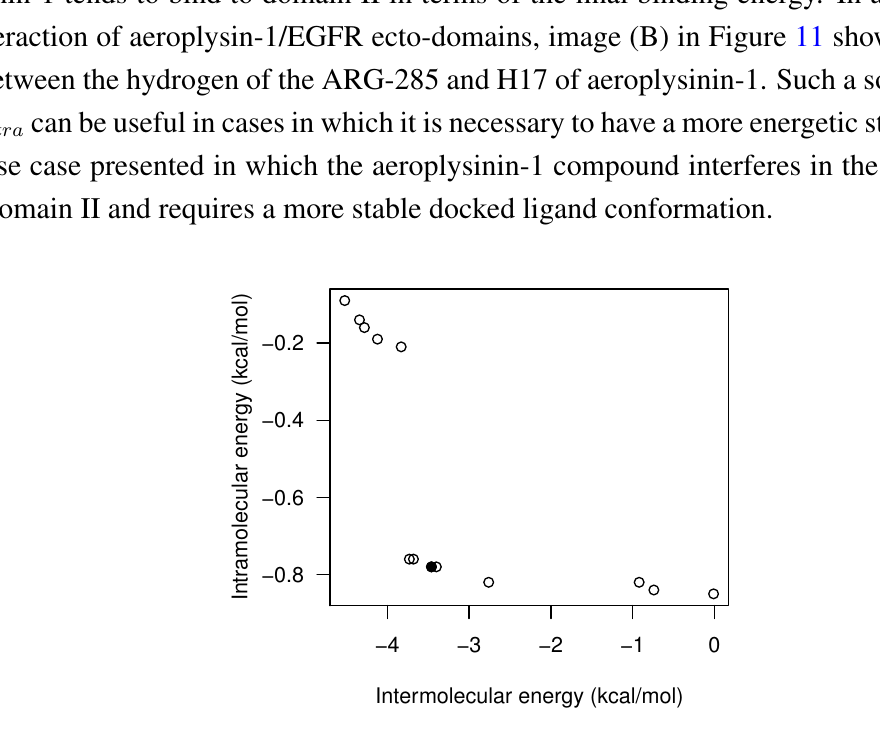
and E values are − 3.46 inter intra